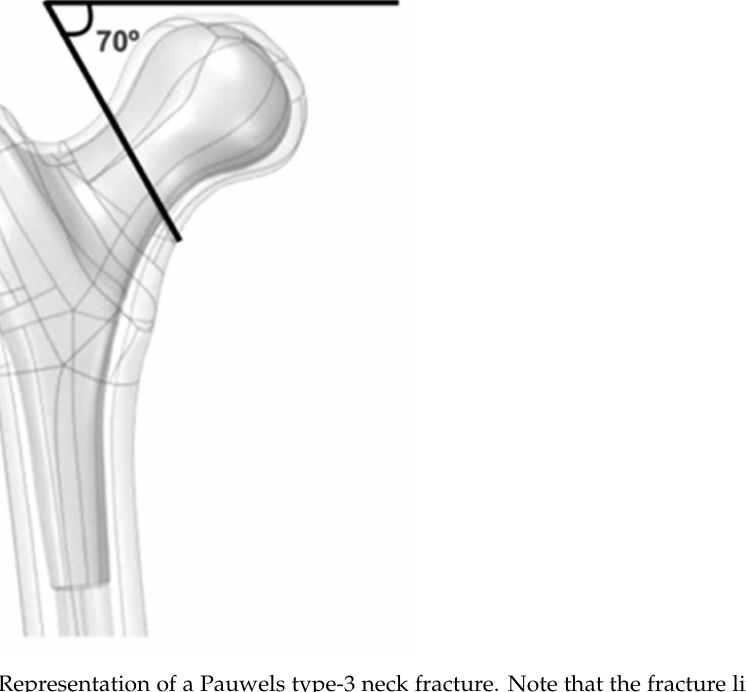
Figure 1. Representation of a Pauwels type-3 neck fracture. Note that the fracture line is oriented 70 degrees from the horizontal.